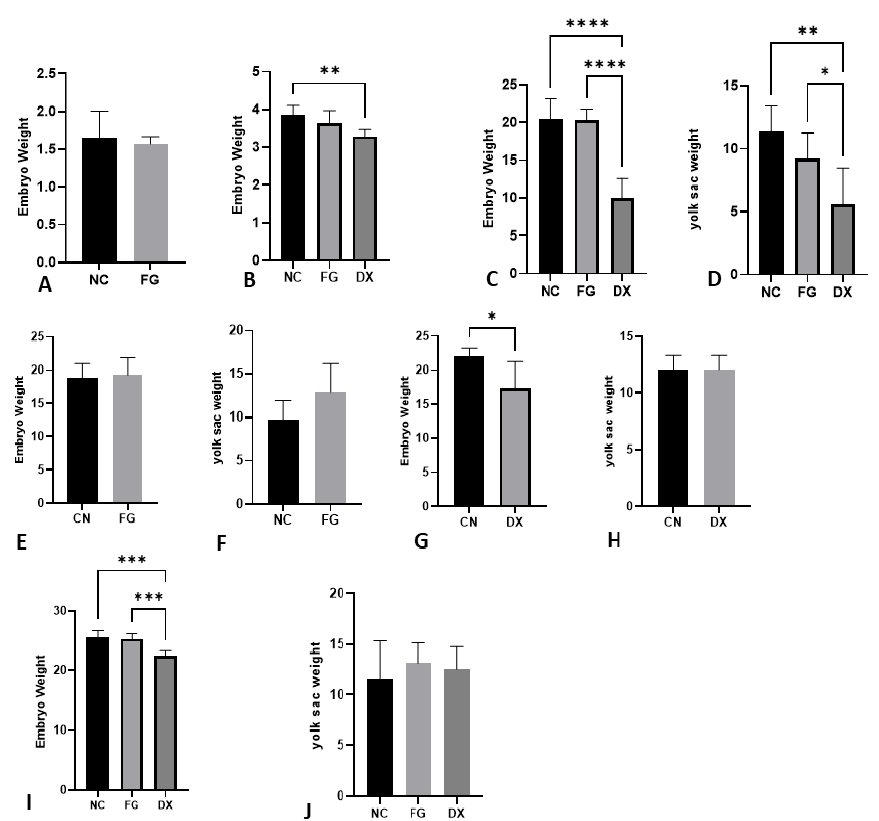
Figure 3. Adjusted embryo and yolk weight in grams at different ages and treatments. Embryo weight inoculated at 0 EID ( A ), 3 EID ( B ), 7 EID ( C ) inoculated via SM, 10 EID inoculated with FG via CAM ( E ), 10 EID inoculated with DX via SM ( G ), 12 EID inoculated at SH ( I ). Yolk sac weight at 7 EID ( D ), 10 EID inoculated with FG via CAM ( F ), 10 EID inoculated with DX ( H ) via SM, 12 EID ( J ) inoculated at SH. In CE inoculated at 0 EID, the CE of the DX group died. We could not weigh the yolk sac of embryos inoculated with the DX at 0 and 3 EID because they disintegrated during manipulation. The asterisks symbols indicate a statistical difference between the groups (* = p ≤ 0.05; ** = p ≤ 0.01; *** = p ≤ 0.001; **** = p ≤ 0.0001). NC: Negative control. FG: Filgrastim. DX: Dexamethasone.